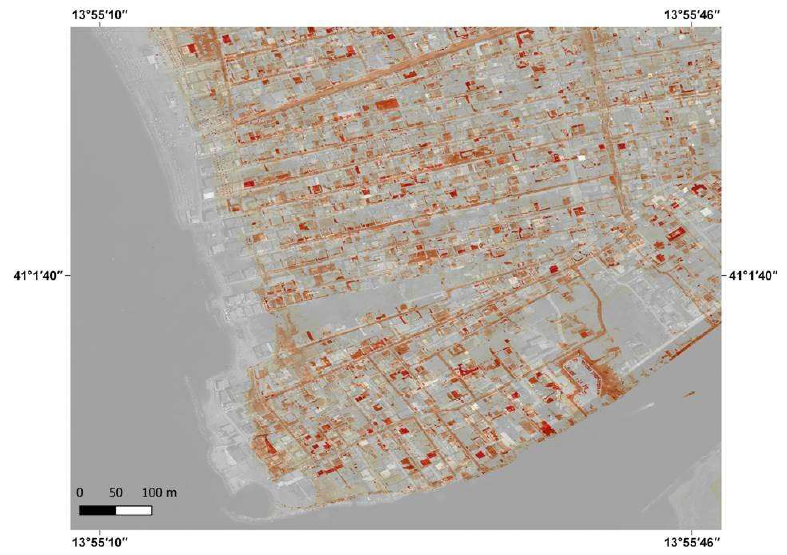
Figure 13. Shift between the orthorectified image (red) and the low-level corrected image (grey).